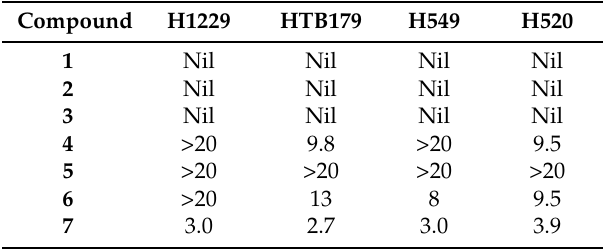
Table 3. Cytotoxic activity (mean value of IC 50 at µ M) of compounds 1 ´ 7 . Compound H1229 HTB179 H549